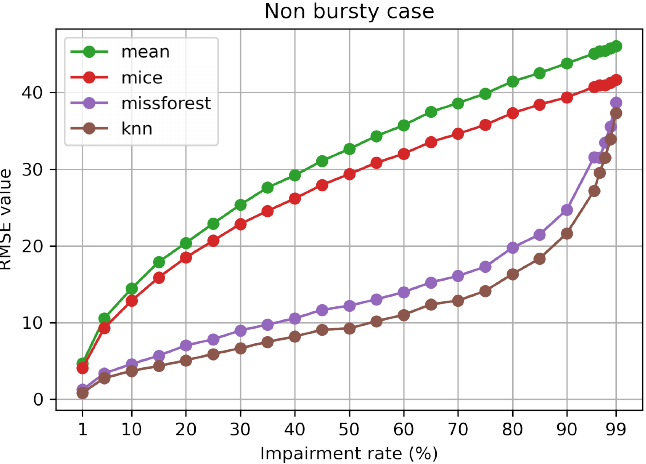
Figure 2. RMSE value in relation to impairment rate (%) for the non-bursty